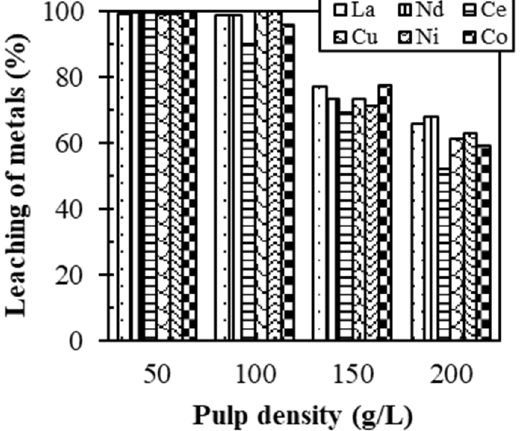
Figure 7. Effect of pulp density on the leaching of rare earth elements (La, Ce and Nd) and valuable metals (Cu, Ni and Co) [Solid: black powder; liquid: 2 M H 2 SO 4 ; additive: 10% H 2 O 2 ( v / v ); time: 60 min; temperature: 75 °C].